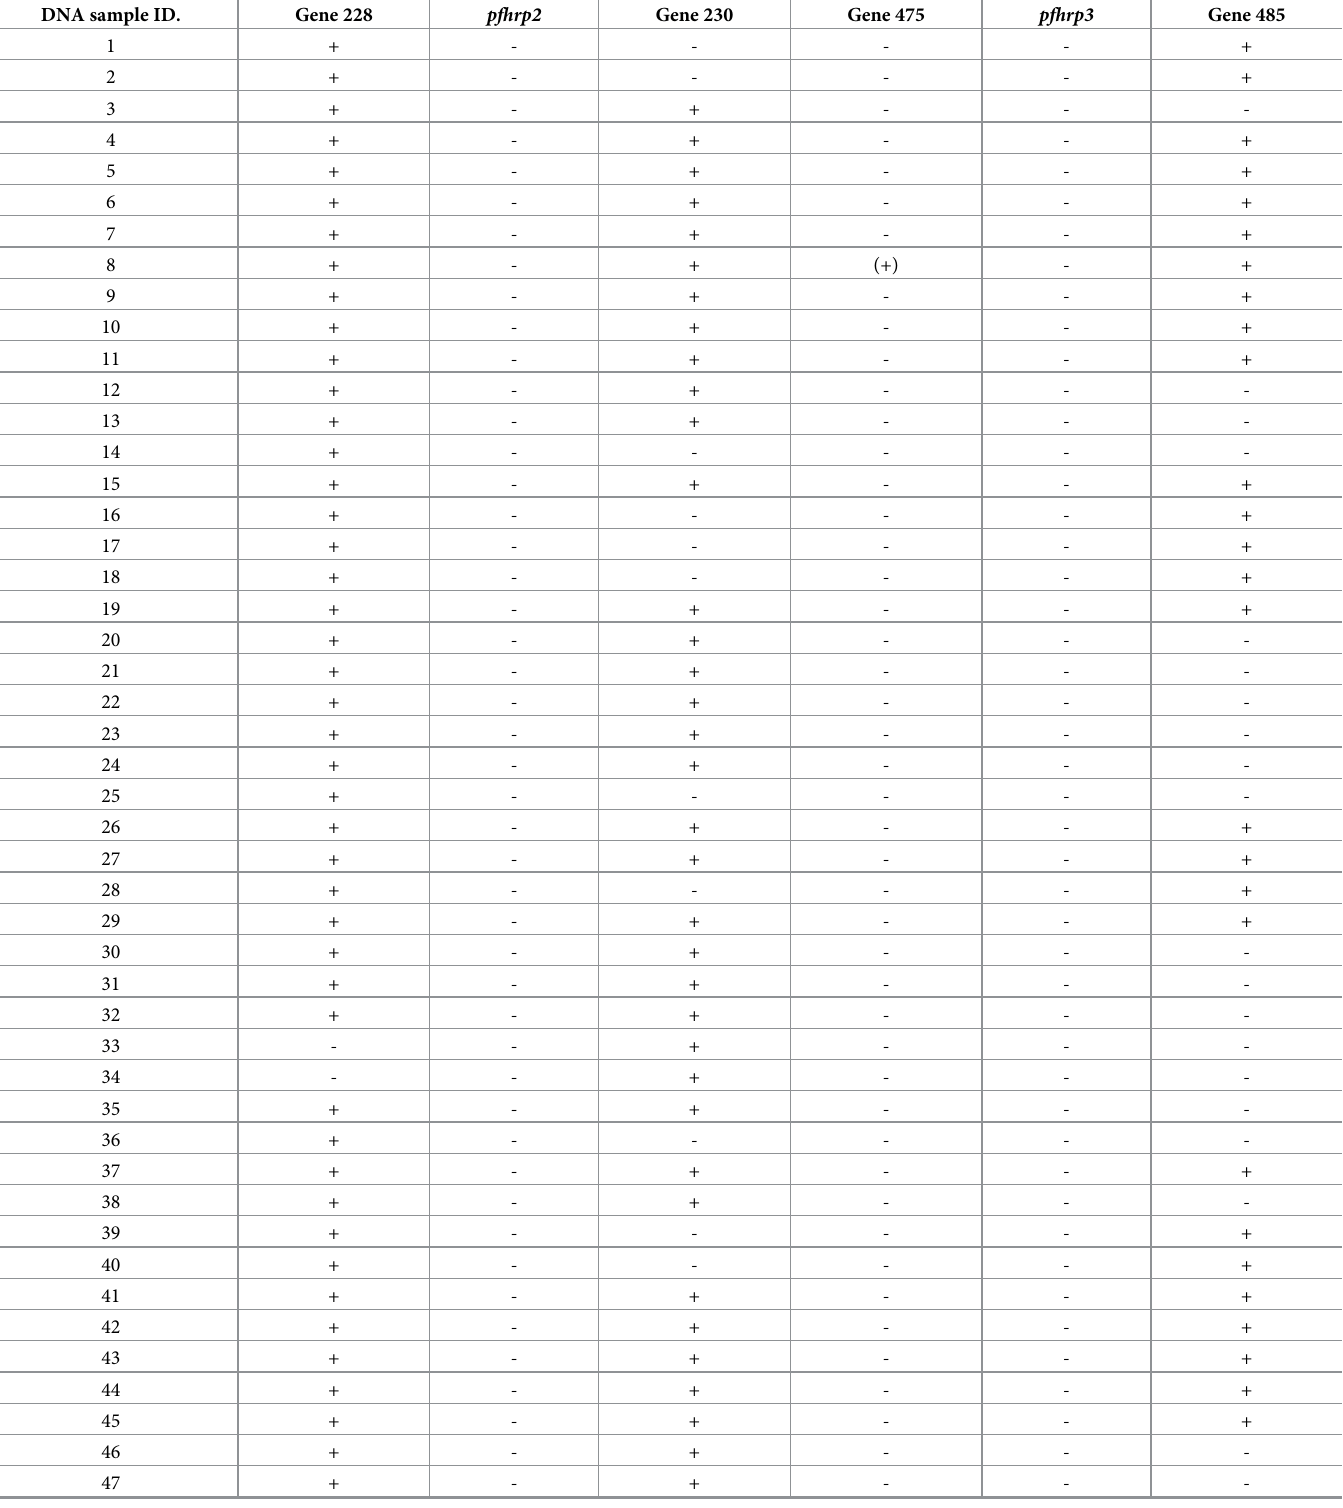
Table 3. Extension of deletions of pfhrp 2 and pfhrp 3 genes, the respective flanking regions and exon primers used in Ethiopian isolates. DNA sample